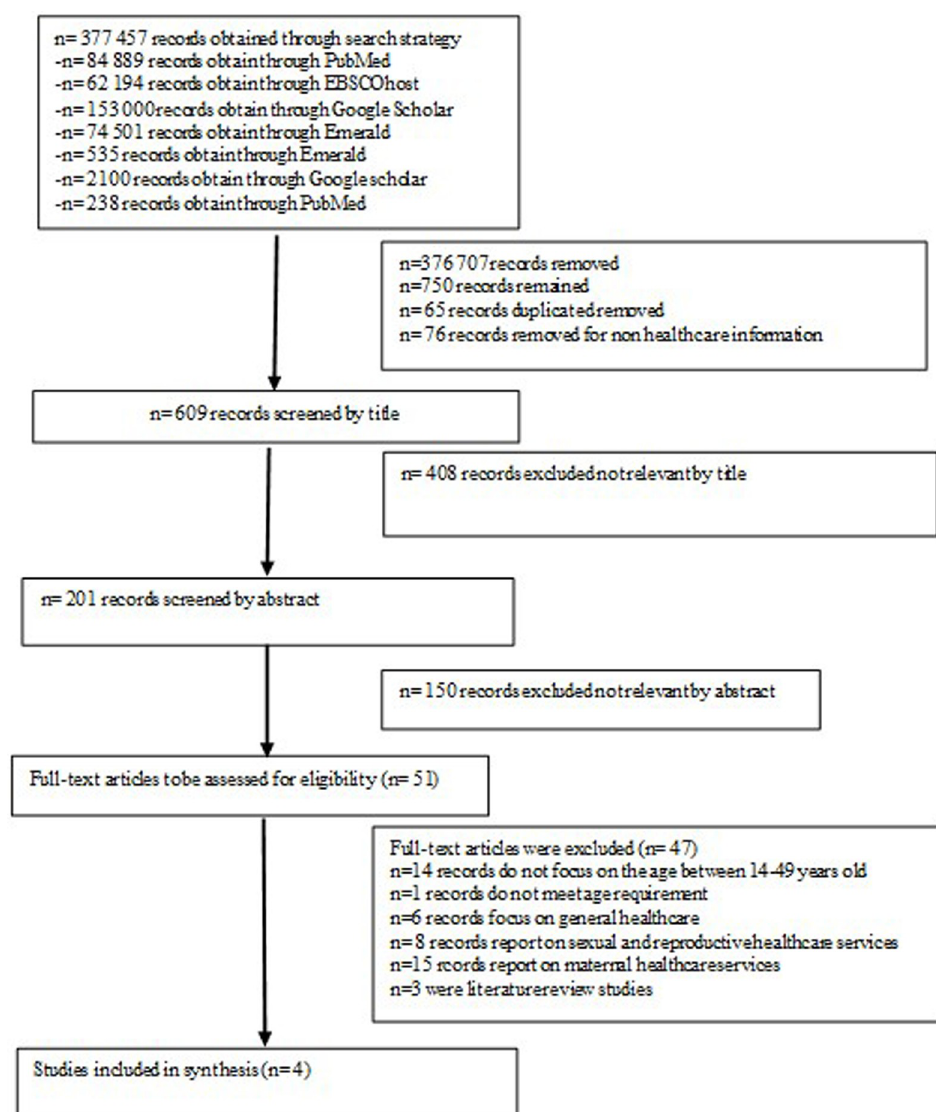
Fig 1. Schematic diagram of the selection process for the studies used for the scoping